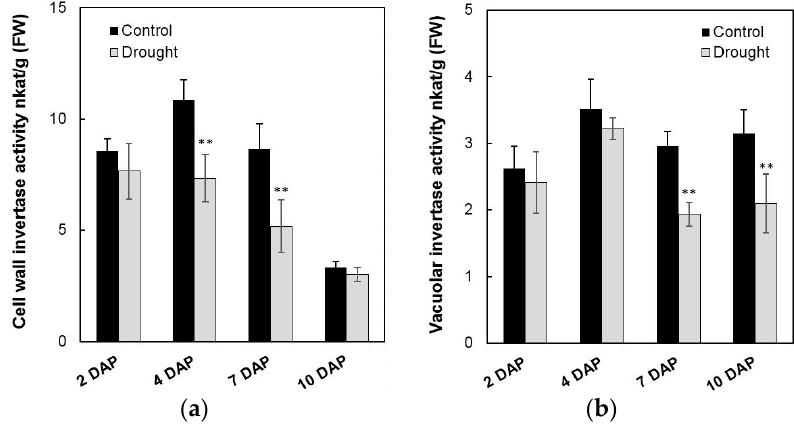
Figure 11. Effect of drought stress on cell wall invertase activities ( a ) and vacuolar invertase activities ( b ) in young maize kernels. Data represents mean ± SE of at least four independent biological replicates. Asterisks indicate significant differences in comparison with the control using a Student’s t -test: ** p < 0.01.